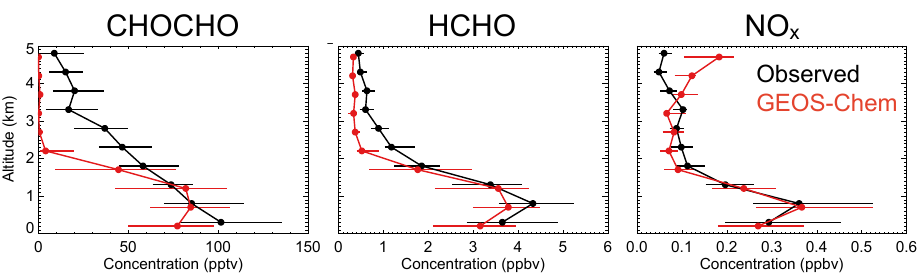
Figure 3. Median vertical profiles of CHOCHO, HCHO, and NO x concentrations during SENEX (1 June–10 July 2013). Observed concen- trations (Min et al., 2016; Cazorla et al., 2015; Pollack et al., 2010) are compared to GEOS-Chem model values sampled along the flight tracks. Horizontal bars indicate interquartile range. Altitudes are above ground level